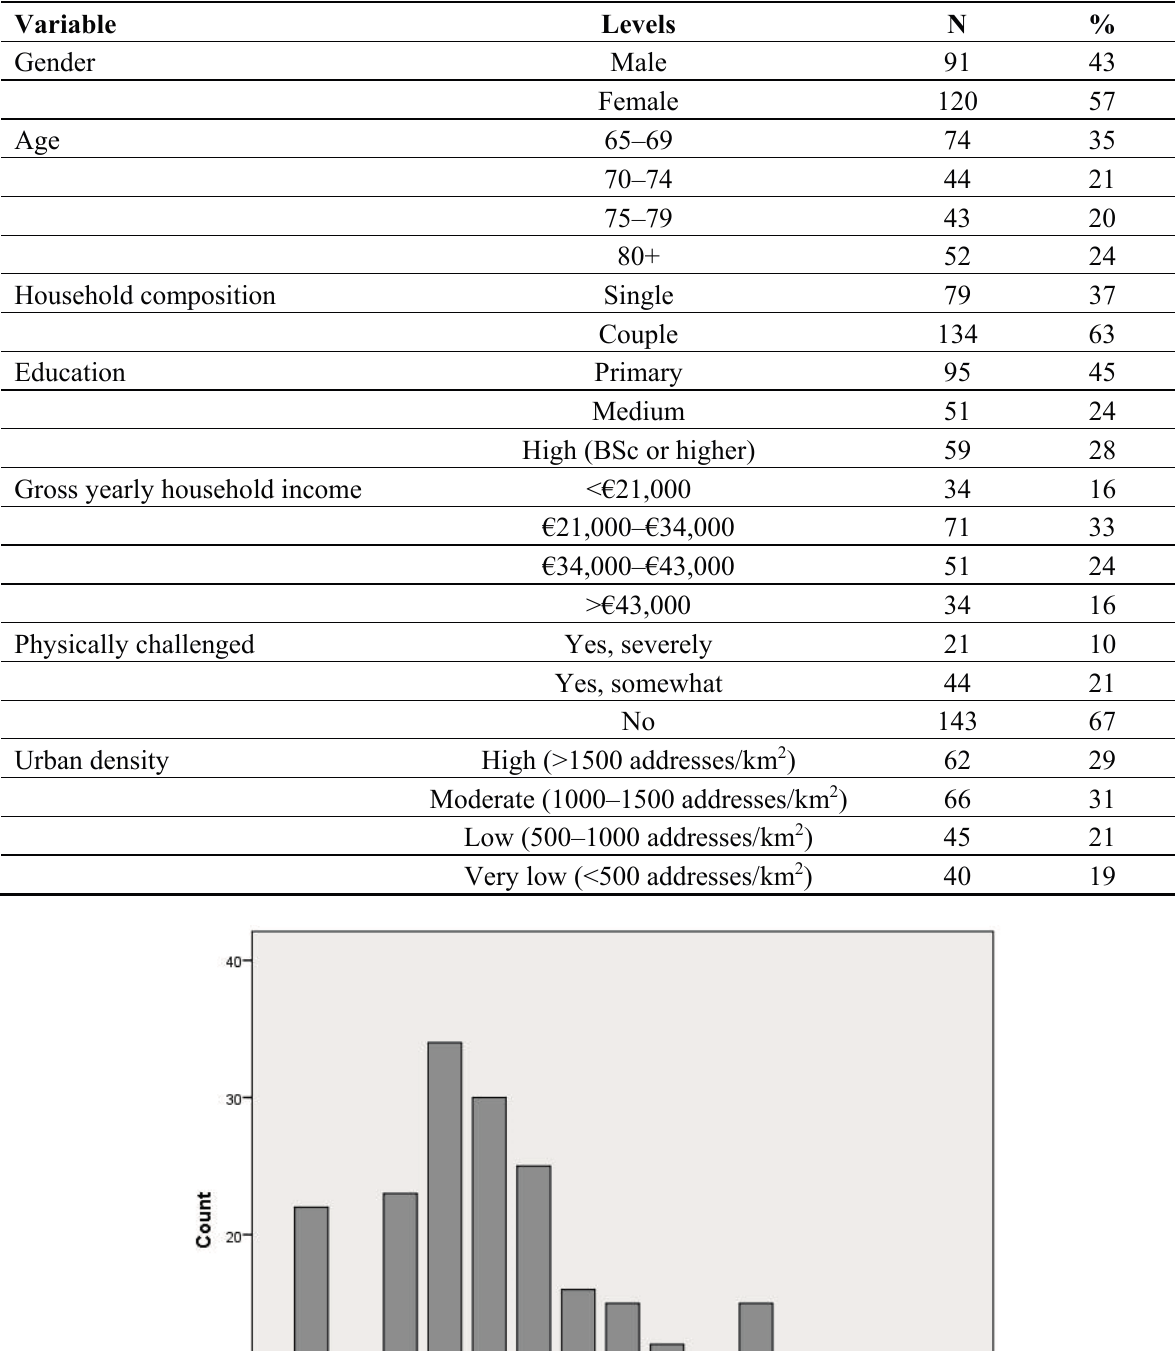
Table 1. Sample characteristics (N = 213).